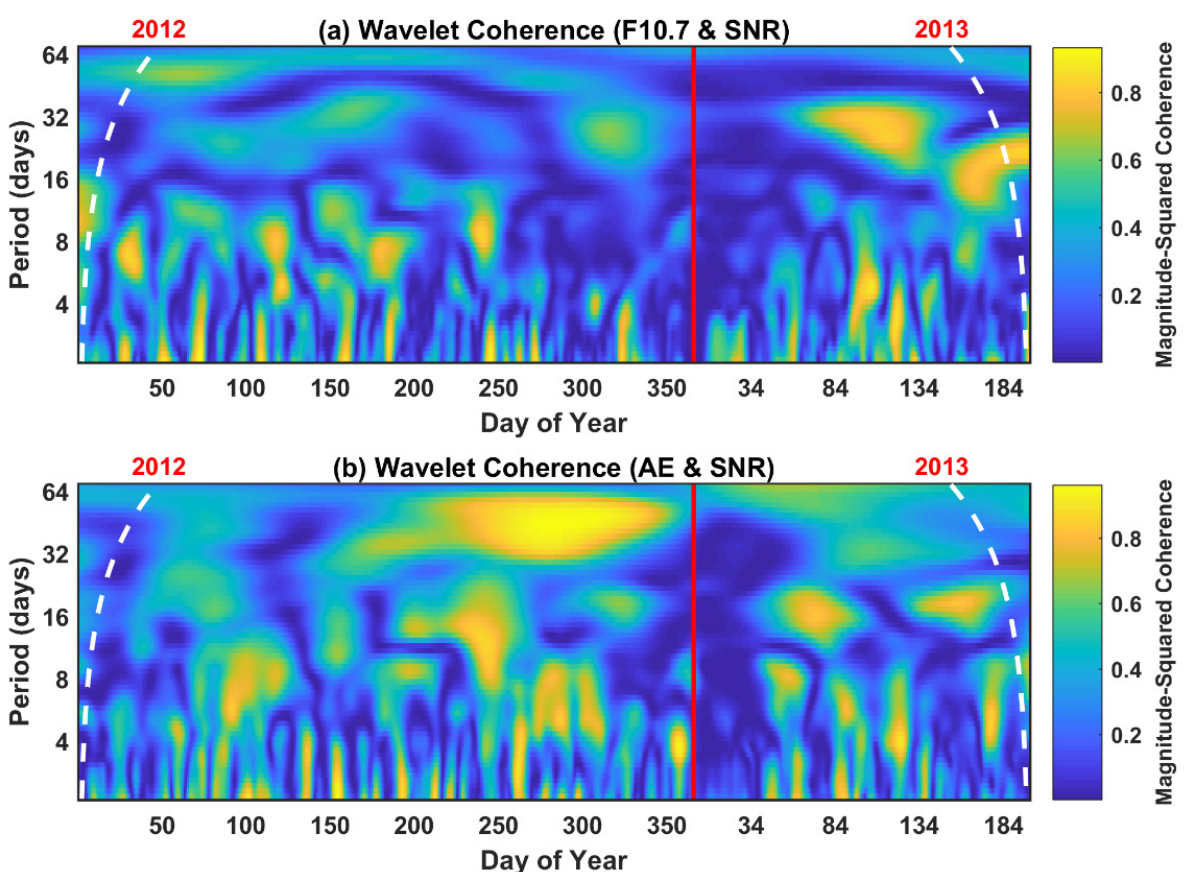
Figure 3. Wavelet coherence between terrestrial driver proxies and nocturnal average SNR at 300 km. ( a ) Wavelet coherence between F10.7 and SNR. ( b ) Wavelet coherence between the AE index and SNR. White dashed lines indicate the cone of influence.